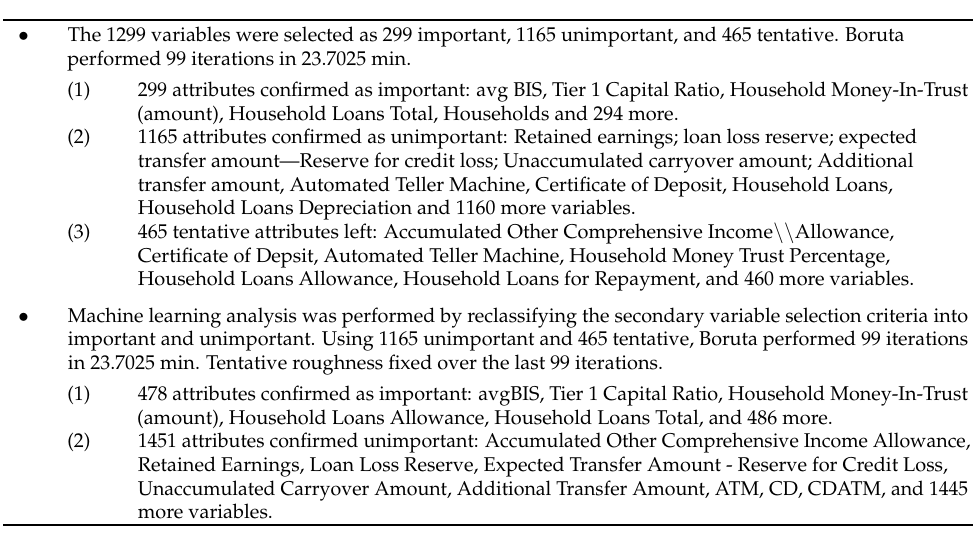
Table 1. Variables Predicting Bank for International SettlementValues Using the Random Forest Boruta Method.